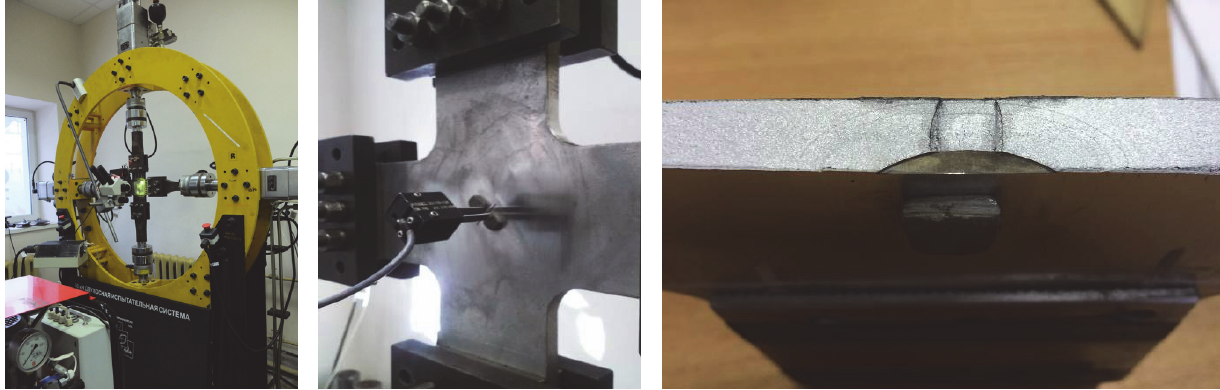
Figure 2: Test equipment for measuring COD and crack path under biaxial loading.